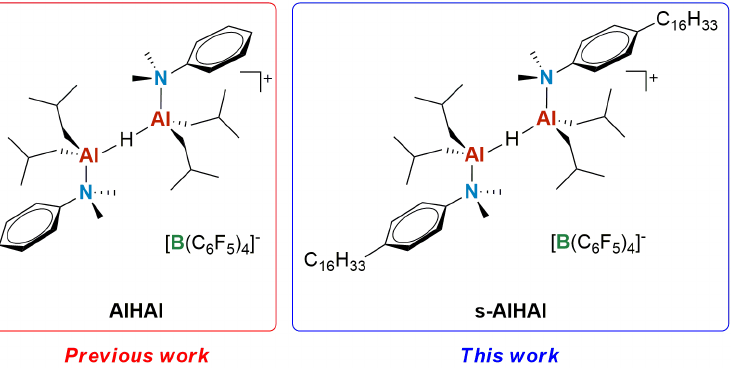
Figure 1. Structures of AlHAl and its hydrocarbon soluble analogue s-AlHAl